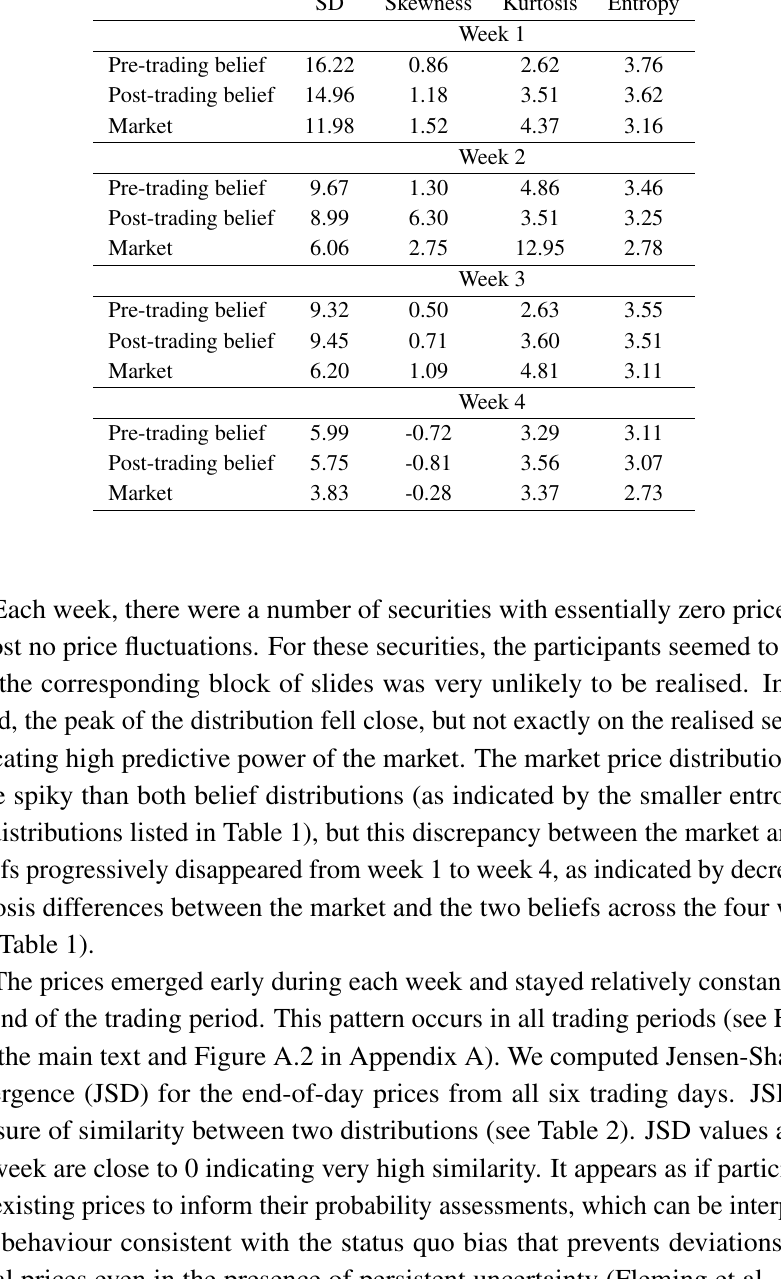
Table 1: Experiment 2: standard deviation, skewness, kurtosis and entropy of the market price distribution, pre-trading belief distribution and post-trading distribution in each of the four weeks of the experiment.